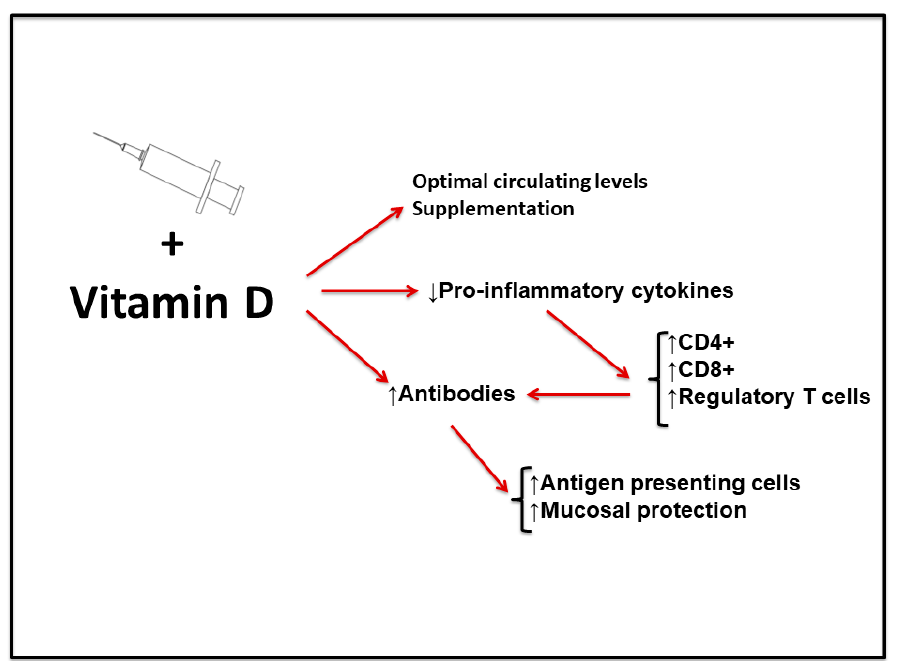
Figure 2. Scheme of the proposed adjuvant effect of vitamin D for COVID-19 vaccination. Optimal circulating levels or supplementation with vitamin D may work as an adjuvant for COVID vaccination. Proposed mechanisms are attenuation of pro-inflammatory cytokine production and increasing the production of antibodies. ( ↑ ) Indicates activated process/increased number and ( ↓ ) indicates decreased production.